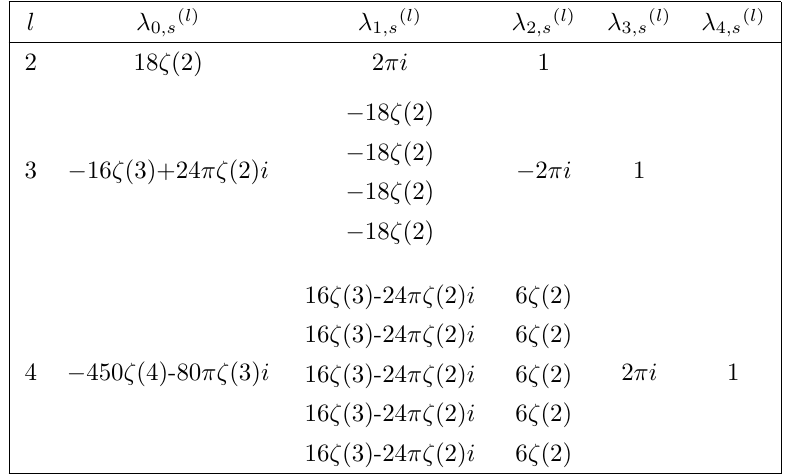
Table 4 . Coefficients giving the non-equal mass Feynman integral in the MUM point Frobenius basis of subsection